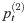
Dynamics of the time-varying second-digit probability pt(2).Time-varying second-digit probability for digits 0 to 9 (p0,t(2),…,p9,t(2)) are presented from top left to bottom right. The chart further includes the posterior mean (solid line) and 95% credible bands (shaded areas) of pd,t(2), the sample empirical distribution (point), and Benford’s distribution (dashed line).